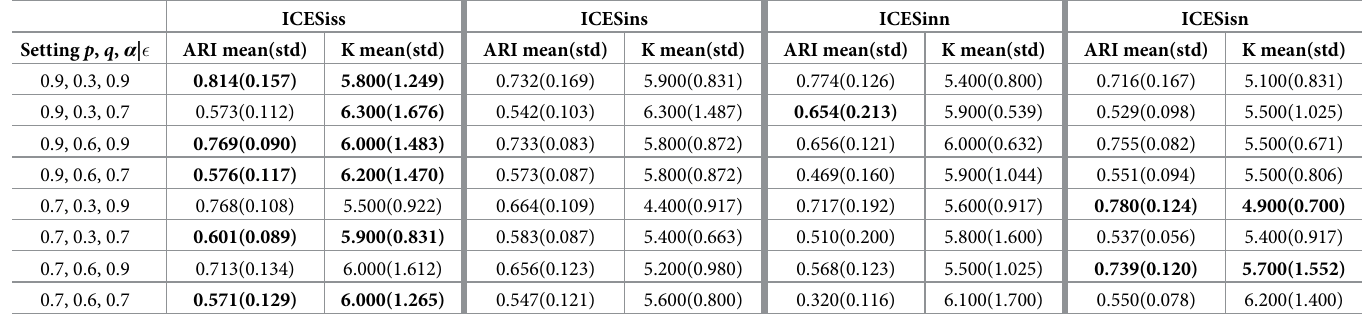
Table 19. The performance of ICESi methods at small-size networks combining quantitative and categorical features at the nodes: The average ARI index and its standard deviation over 10 different data sets. ICESiss ICESins ICESinn ICESisn Setting p , q , α |